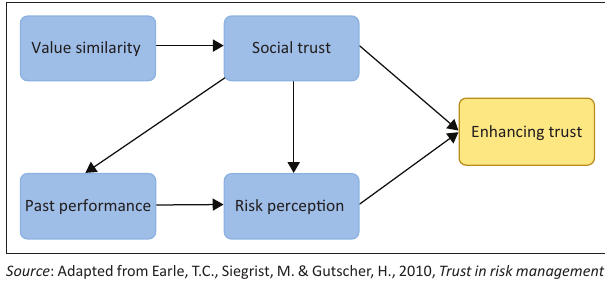
FIGURE 1: Influence of four core concepts upon enhancing trust.